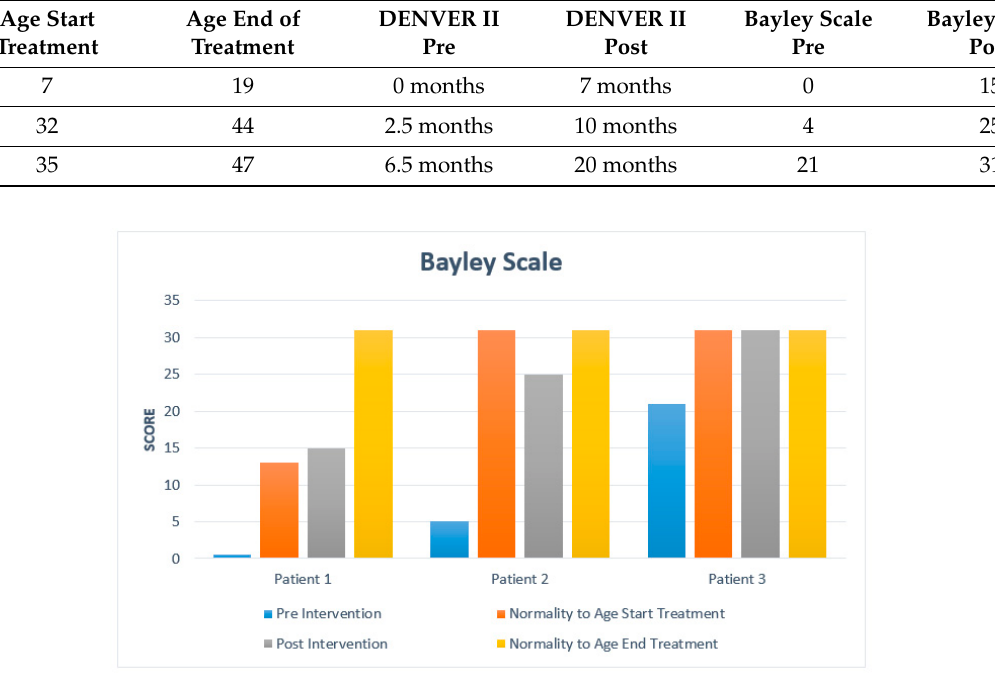
Figure 2. Patient score and comparison with normality based on Bayley Scale.